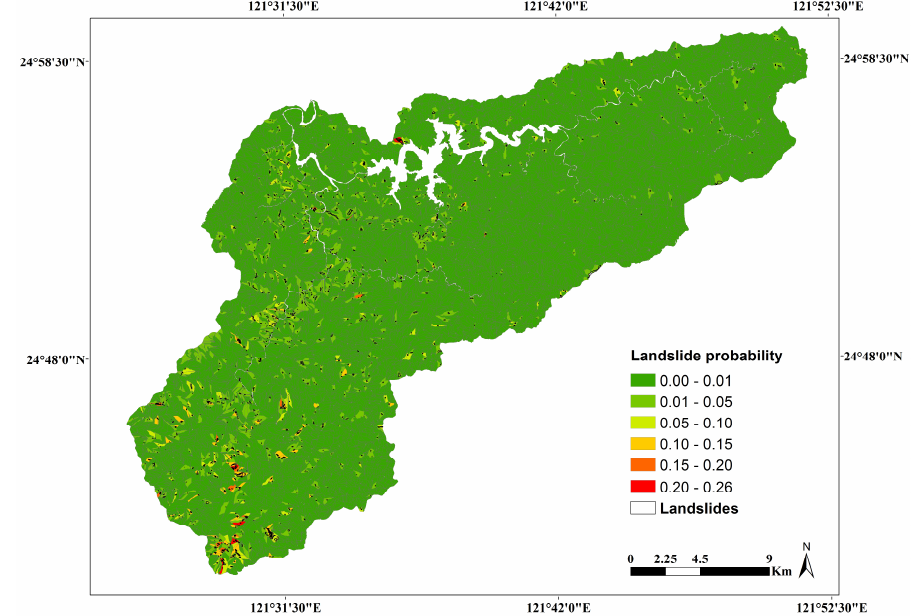
Figure 10. The probability that at least one rainfall event exceeds the threshold of discrete rainfall group and one landslide will also occur during the future one-year period within the Taipei Water Source Domain.